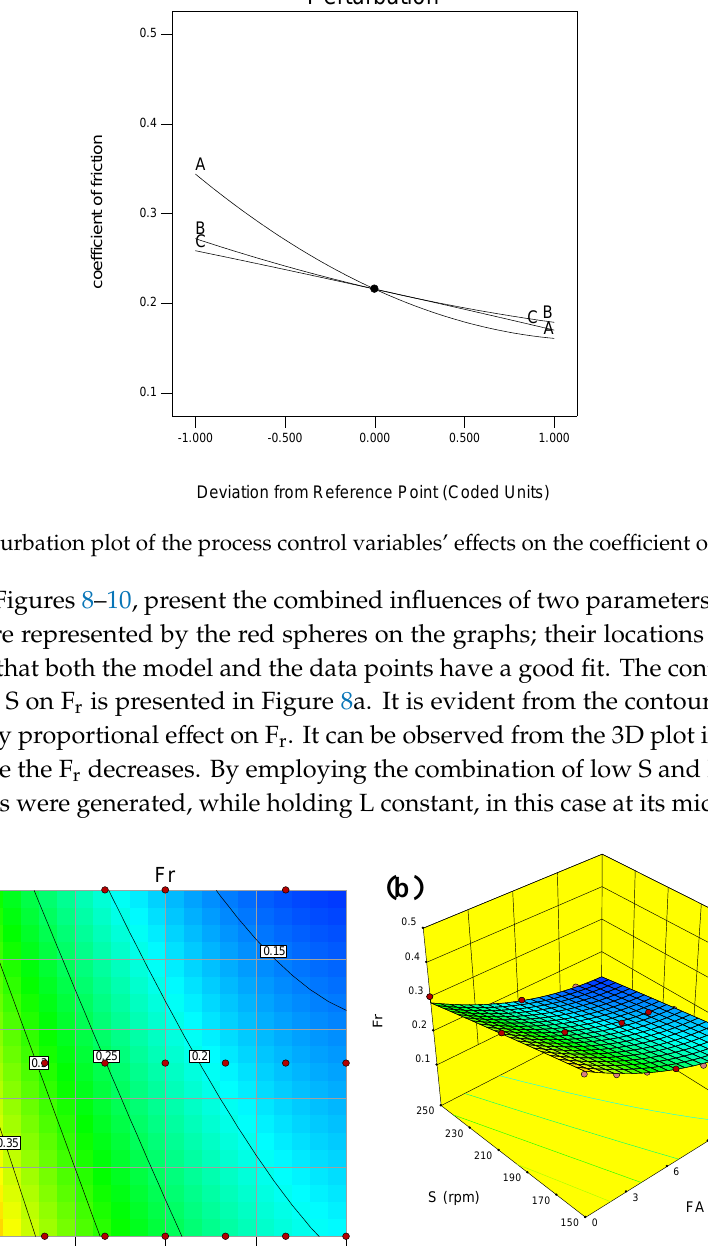
Figure 8. View of the interactive effect of FA and S on Fr, ( a ) contour lines 2D, ( b ) 3D.